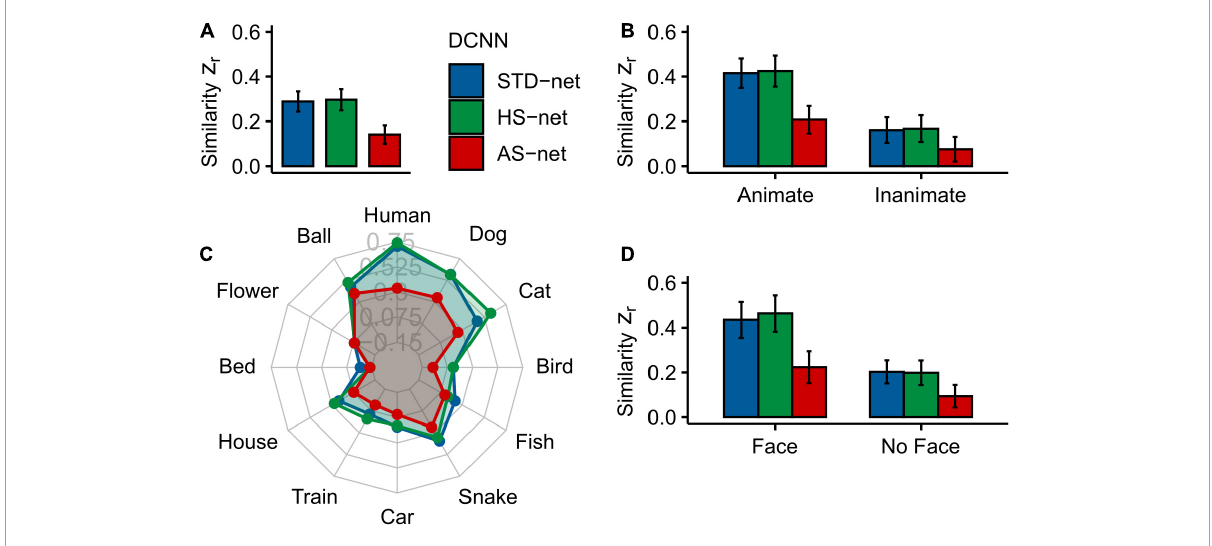
FIGURE3 Mean Fisher’s Z transformed Pearson correlations between DCNN GradCAMs and human eye tracking heatmaps for all individual testing images. (A) Overall similarity of standardly fine-tuned STD-nets, purposefully manipulated HS-nets, and inversely manipulated AS-nets compared to eye tracking heatmaps. (B) Similarity across animacy. (C) Similarity across categories. (D) Similarity across face presence. Error bars display bootstrap confidence